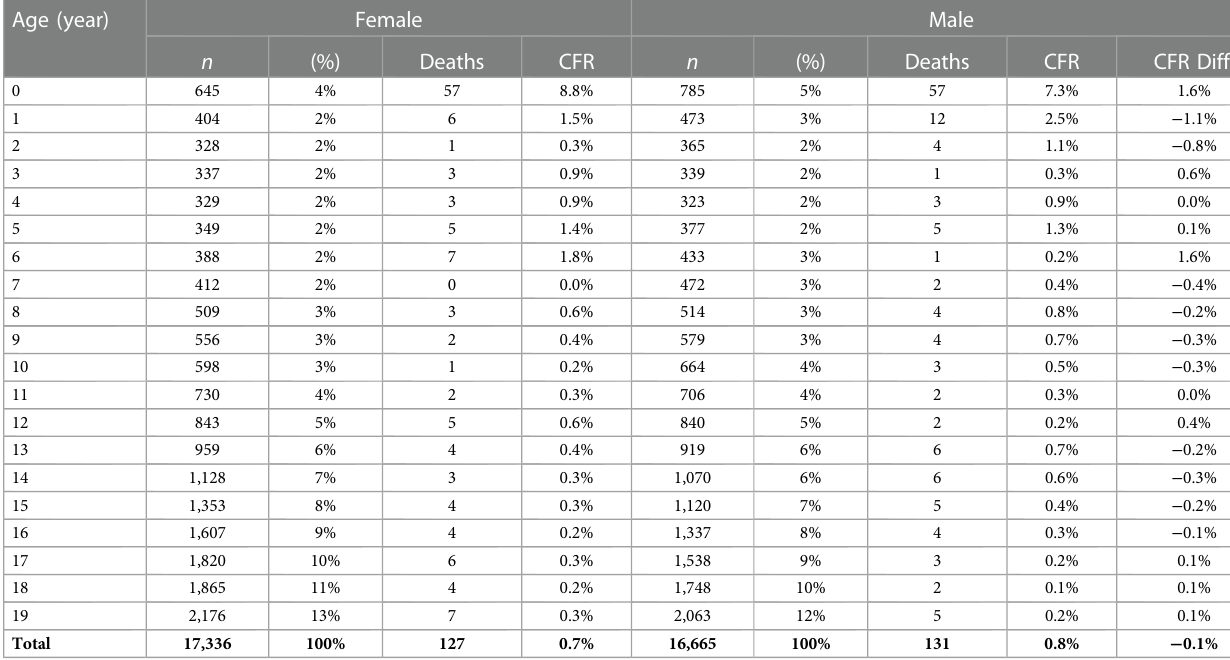
TABLE 2 Age related sex differences between children and adolescents from 0 to 19 years of age. Age (year)